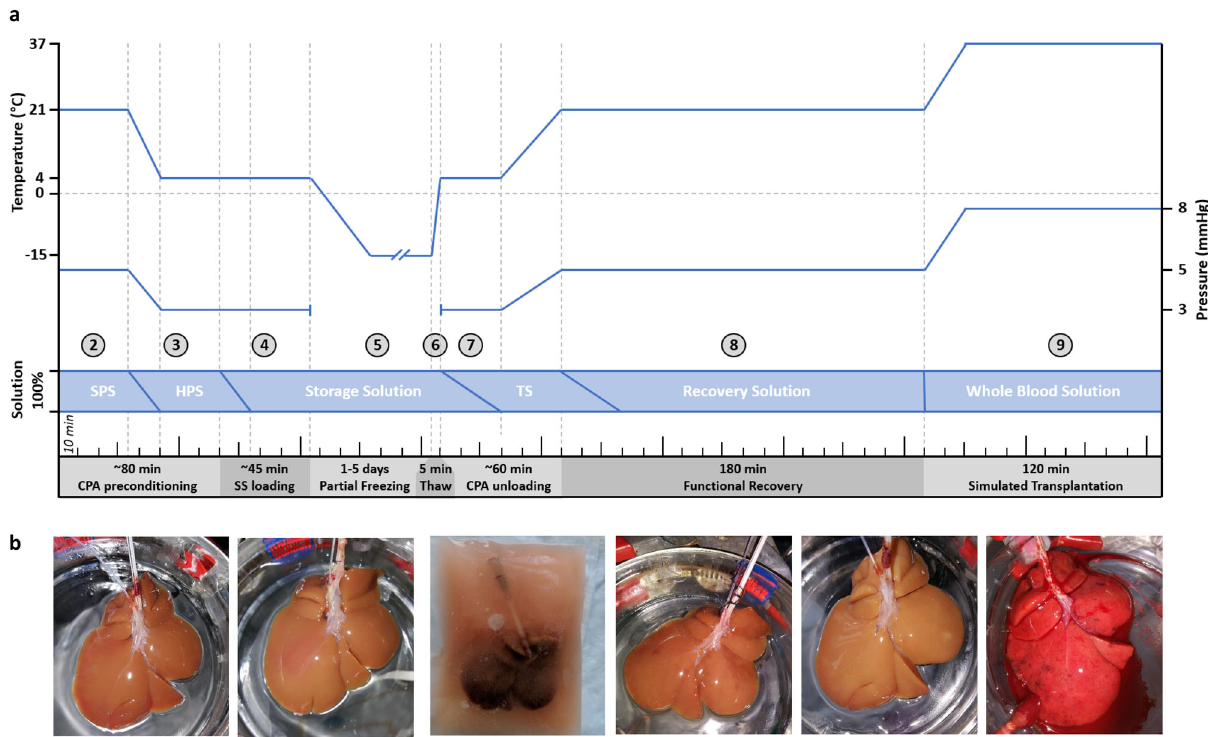
Fig. 1 The partial freezing protocol. a Schematic overview of the partial freezing protocol showing the target perfusion temperature (top blue line) and pressures (bottom blue line) during the subsequent steps in the protocol. Livers were stored at either − 10 or − 15 °C. The numbers in circles match the explanation of the protocol in the introduction and Methods section. The perfusion solutions and the rate of change between the solutions are shown in blue boxes. SPS = subnomothermic preconditioning solution, HPS = hypothermic preloading solution, TS = thawing solution. See Supplementary Table S1 for the exact composition of the solutions. b Photos of the livers during the consecutive steps of the protocol. From left to right; SNMP preloading, HMP preloading, partial freezing, CPA unloading, functional recovery during SNMP, and start of simulated